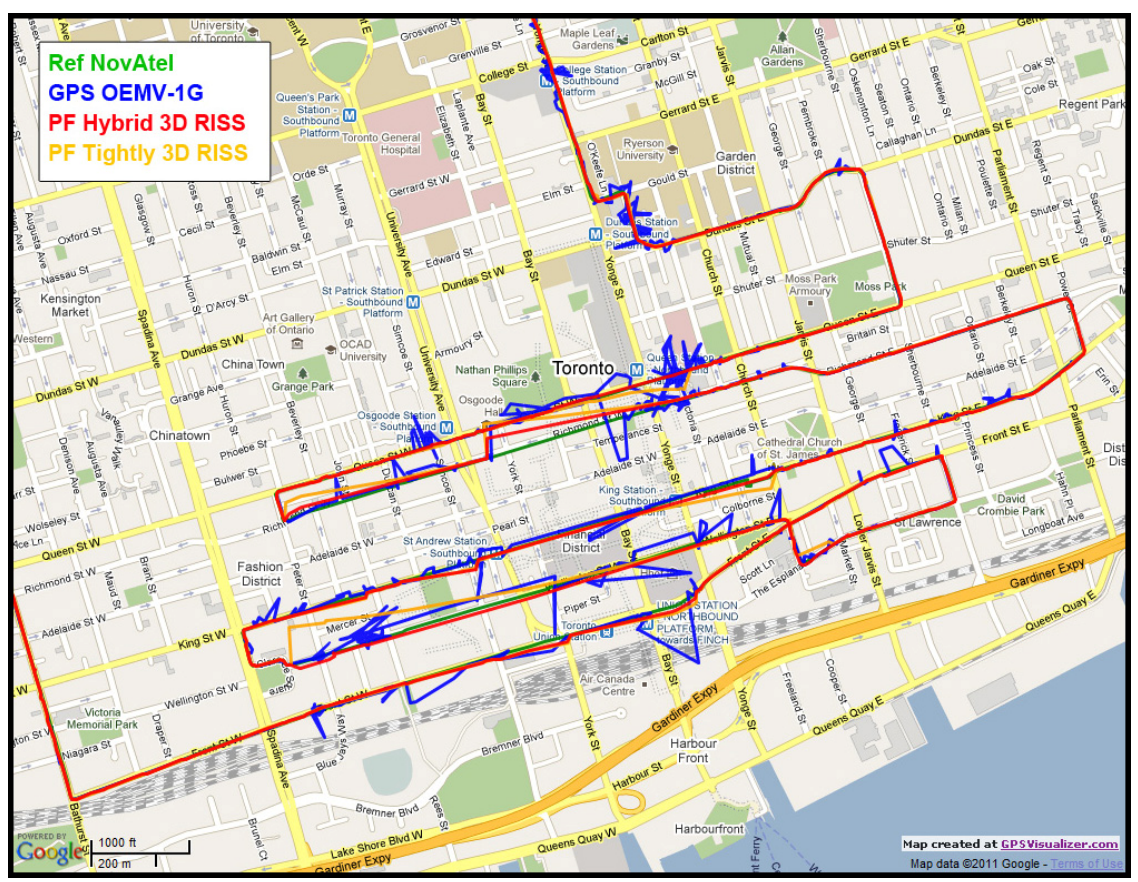
Figure 20. Zoom in on the downtown portion of Toronto trajectory showing the degraded GPS performance and the performance of the proposed navigation